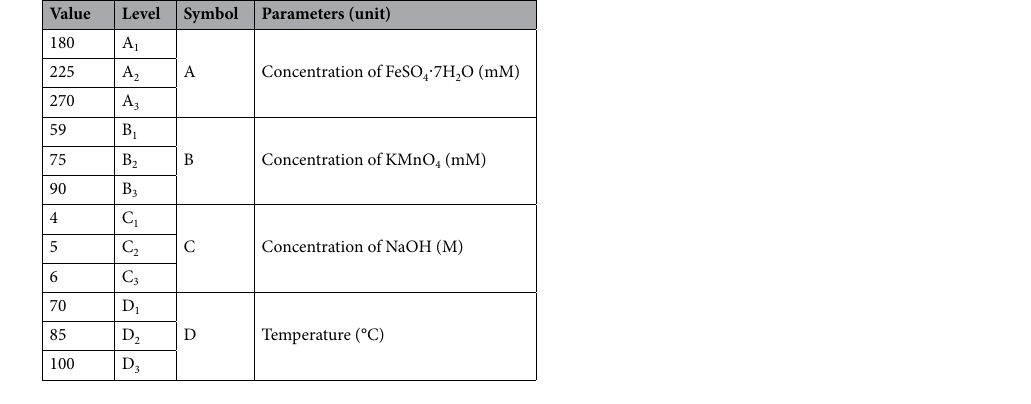
Table 2. Factors and